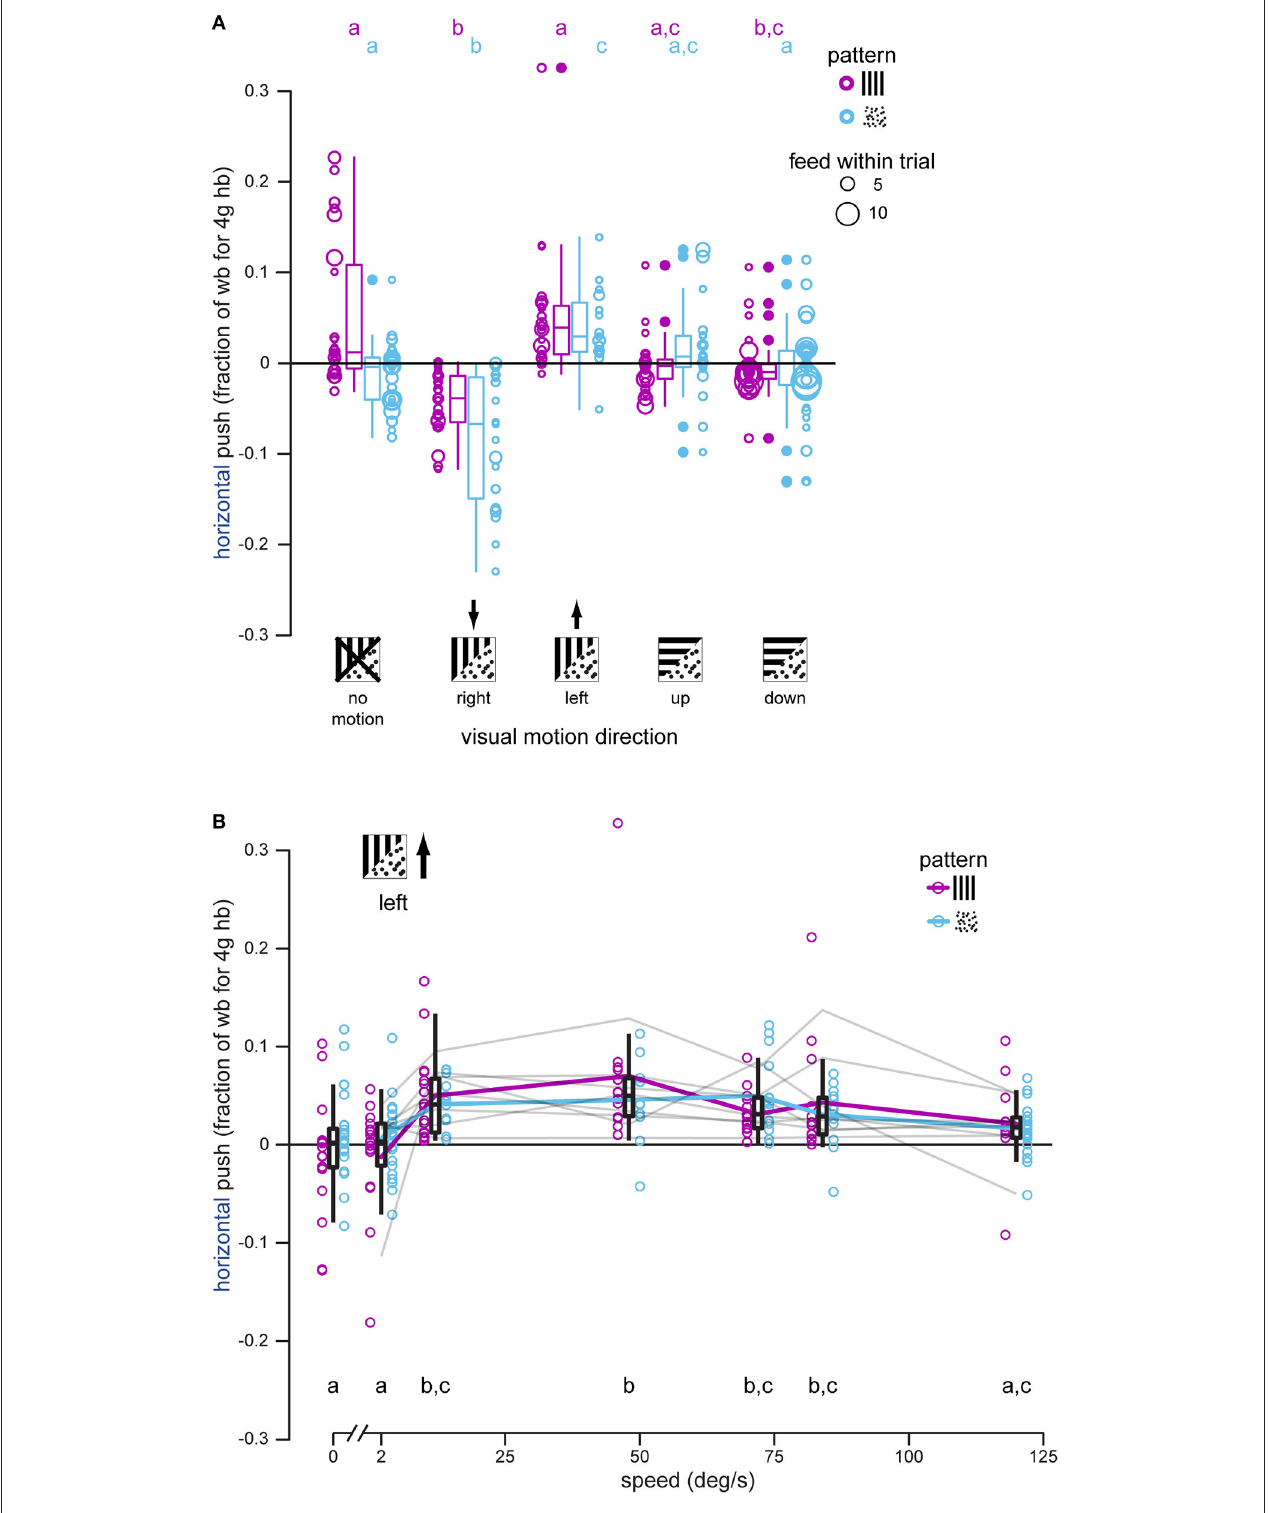
FIGURE 3 | Hummingbirds attempt to stabilize lateral visual motion during docked feeding, especially at intermediate motion speeds. (A) Horizontal push was measured each time a hummingbird docked, and each bird was presented with right-, left-, up-, and down-moving patterns, as well as stationary ones, during feeding. Black arrows indicate the expected push direction if the bird attempts to stabilize the directional visual motion. Gratings had significantly less of an effect than